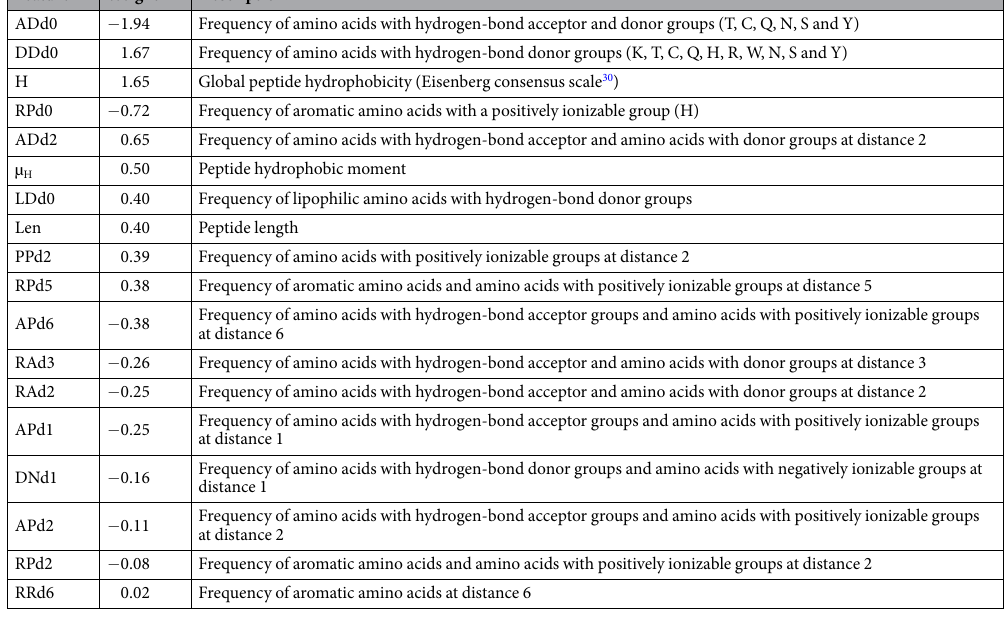
Table 3. The 18 features obtained after covariance elimination and sequential feature selection. The top scoring features are ranked by their absolute support vector machine weight values, as a measure of their relative importance for ACP classification. An interpretation of each feature is